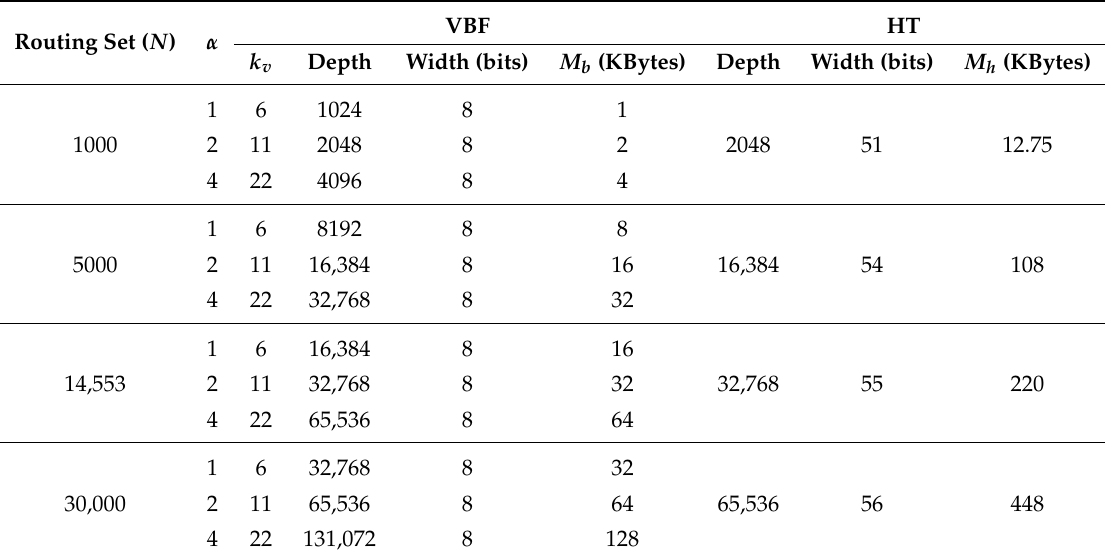
Table 2. Memory requirement of proposed structure.